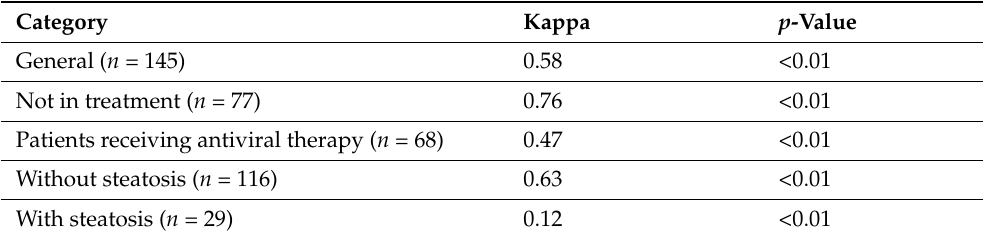
Table 4. Kappa coefficient index of agreement between TE and 2D-SWE in patients not in treatment and patients receiving antiviral therapy, and in patients without and with steatosis.